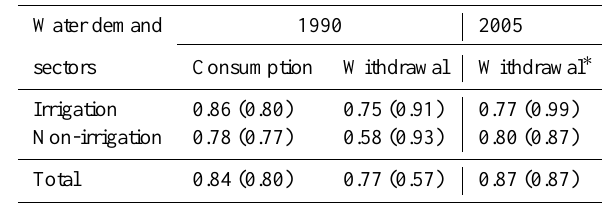
Table 1. Correlation coefficients between GCAM and USGS based on state-level water demand estimates by sector; correlation values in parenthesis are based on the Miwestern states